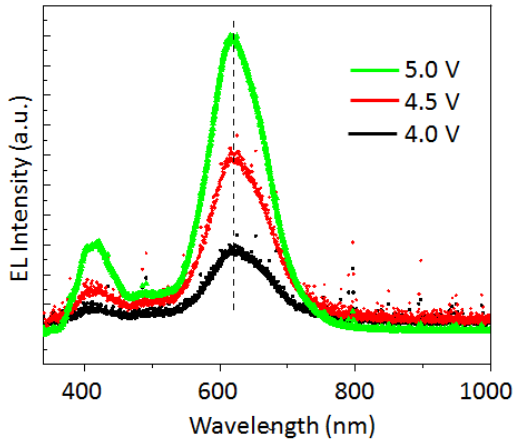
Figure 4. EL spectra at three different bias voltages.